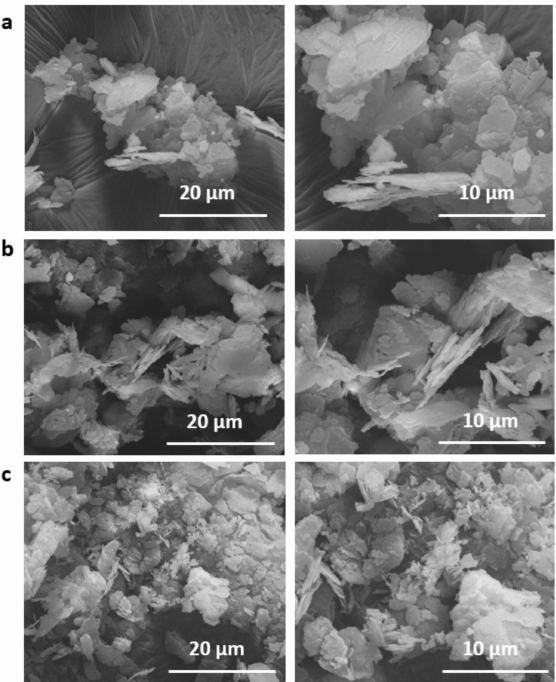
Figure 3. SEM micrographs of kaolinite ( a ), metakaolin ( b ), and silica particles ( c ).